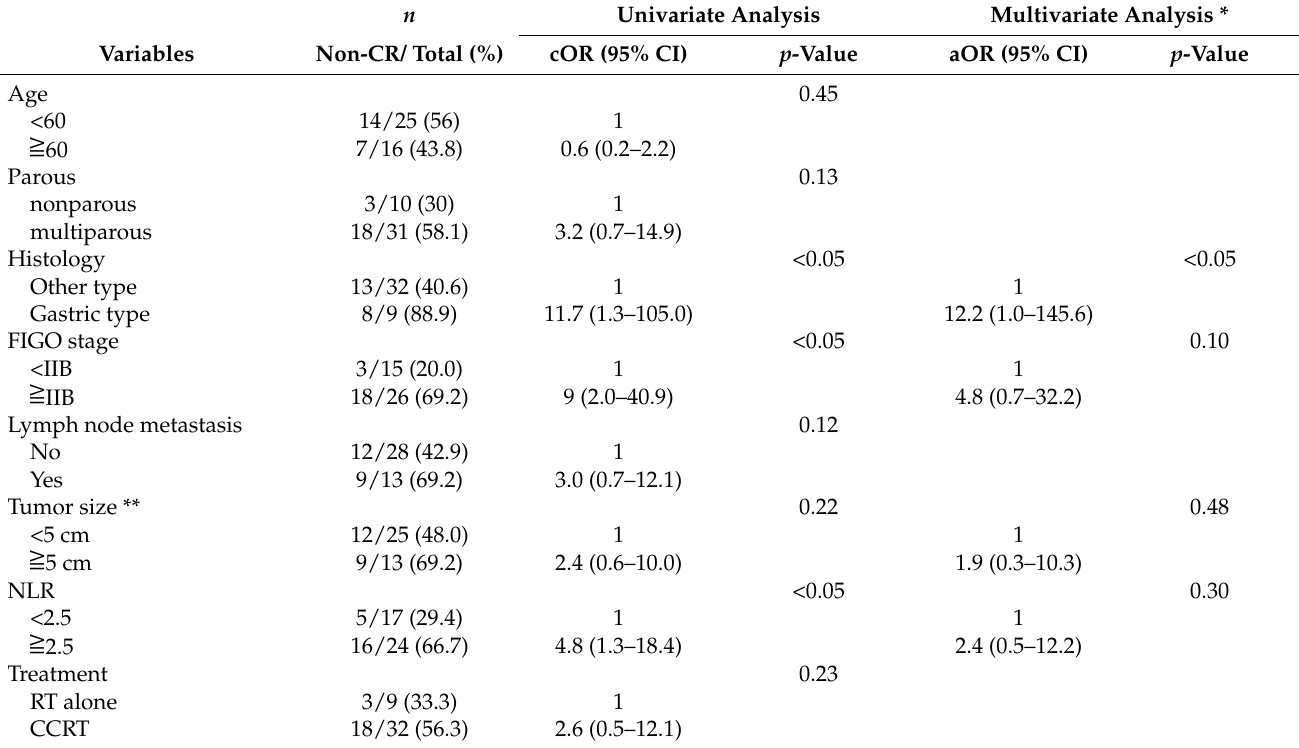
*Adjusted for FIGO stage, histology, tumor size, and NLR. ** Three patients had missing data. Abbreviations: CR, complete response; AC, adenocarcinoma; cOR, crude odds ratio; aOR, adjusted